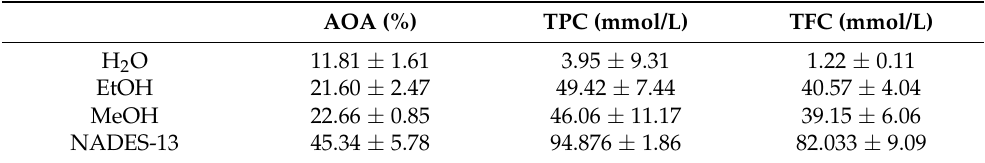
Table 4. Comparison of the extraction efficiencies of NADES (optimum result) with conventional